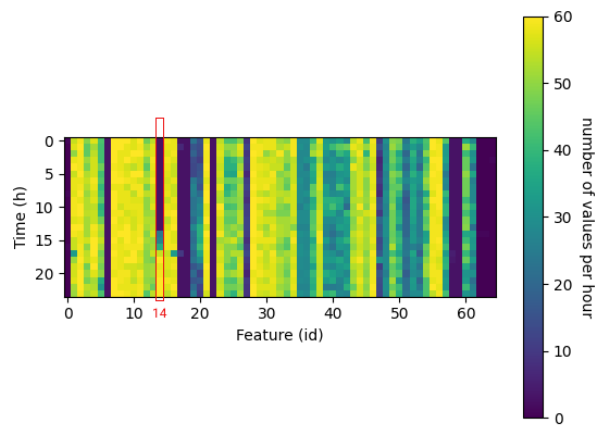
Figure 8. Original sampling of real industrial data from a distillation